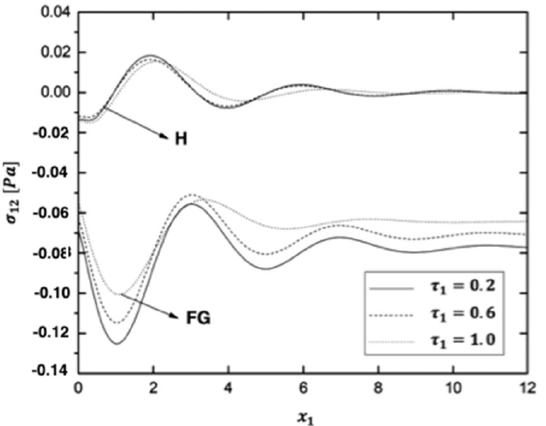
Figure 15. Variation of the thermal stress wave σ 12 along x 1 − axis in the functionally graded (FG) and homogeneous (H) anisotropic fiber-reinforced plates under different values of time characteristic of the laser pulse.